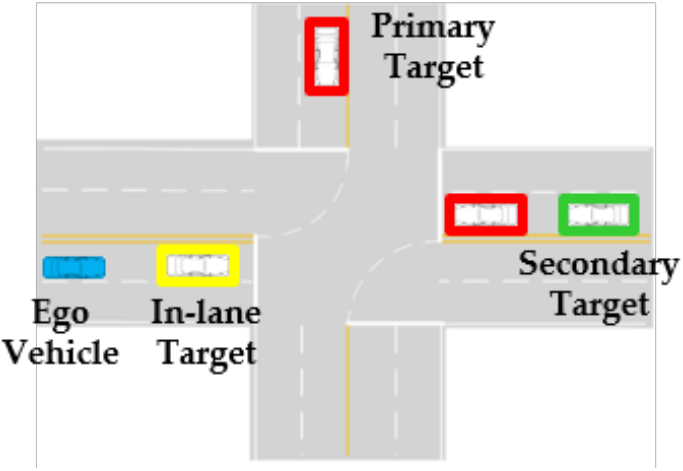
Figure 9. Classification of intersection-approaching targets.